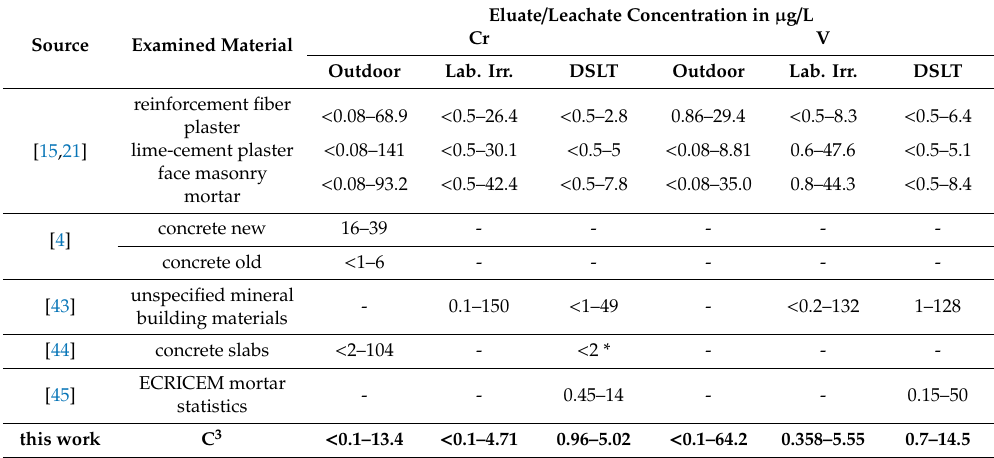
Table 8. Leachate concentrations of chromium and vanadium for di ff erent mineral building